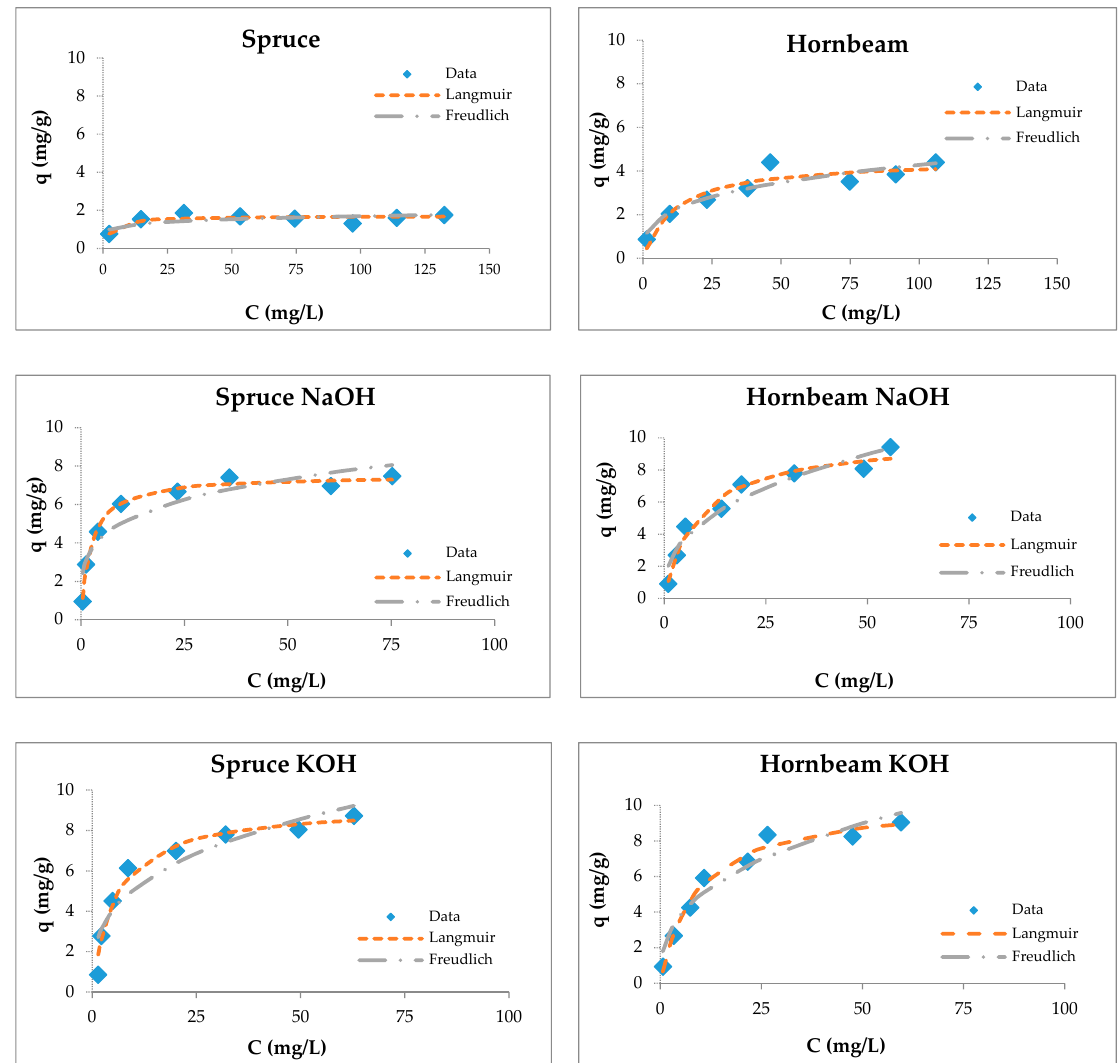
Figure 6. Langmuir and Freundlich isotherms of Zn(II) removal by raw and modified sawdusts.